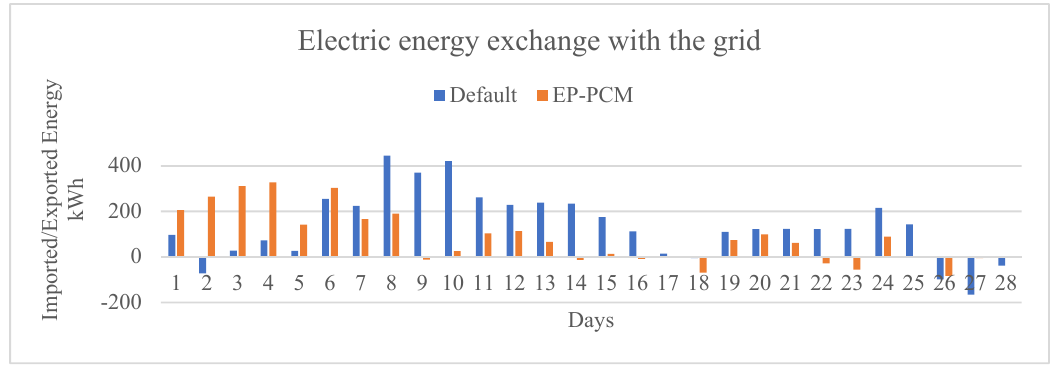
Figure 4. Daily electric energy exchange of nZEB Living Lab with the grid in July 2020.